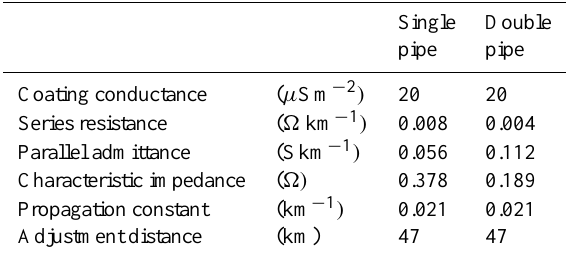
Table 2. Electrical properties of the pipeline of interest between North Bay and Morrisburg (from Boteler and Trichtchenko,